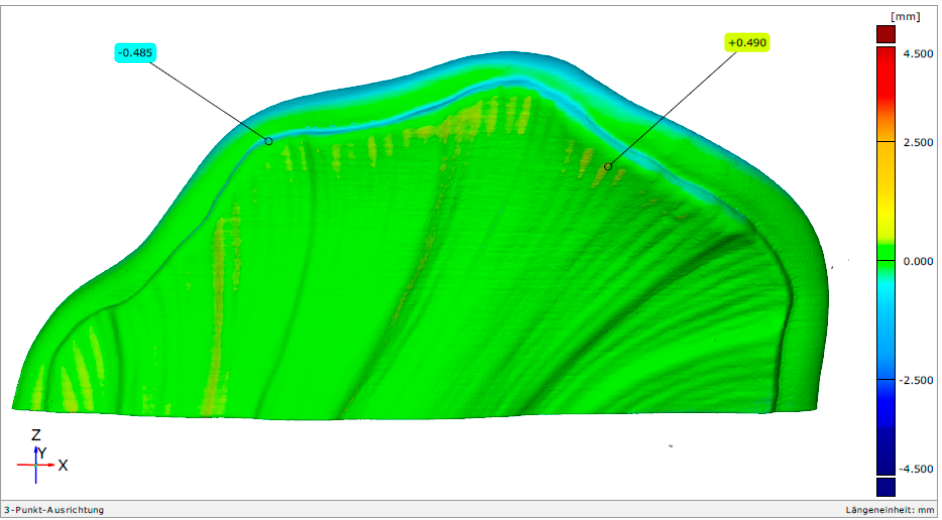
Figure 17. Superimposed fragment 3: manufacturing direction: alternating ( n = 2); sintered.